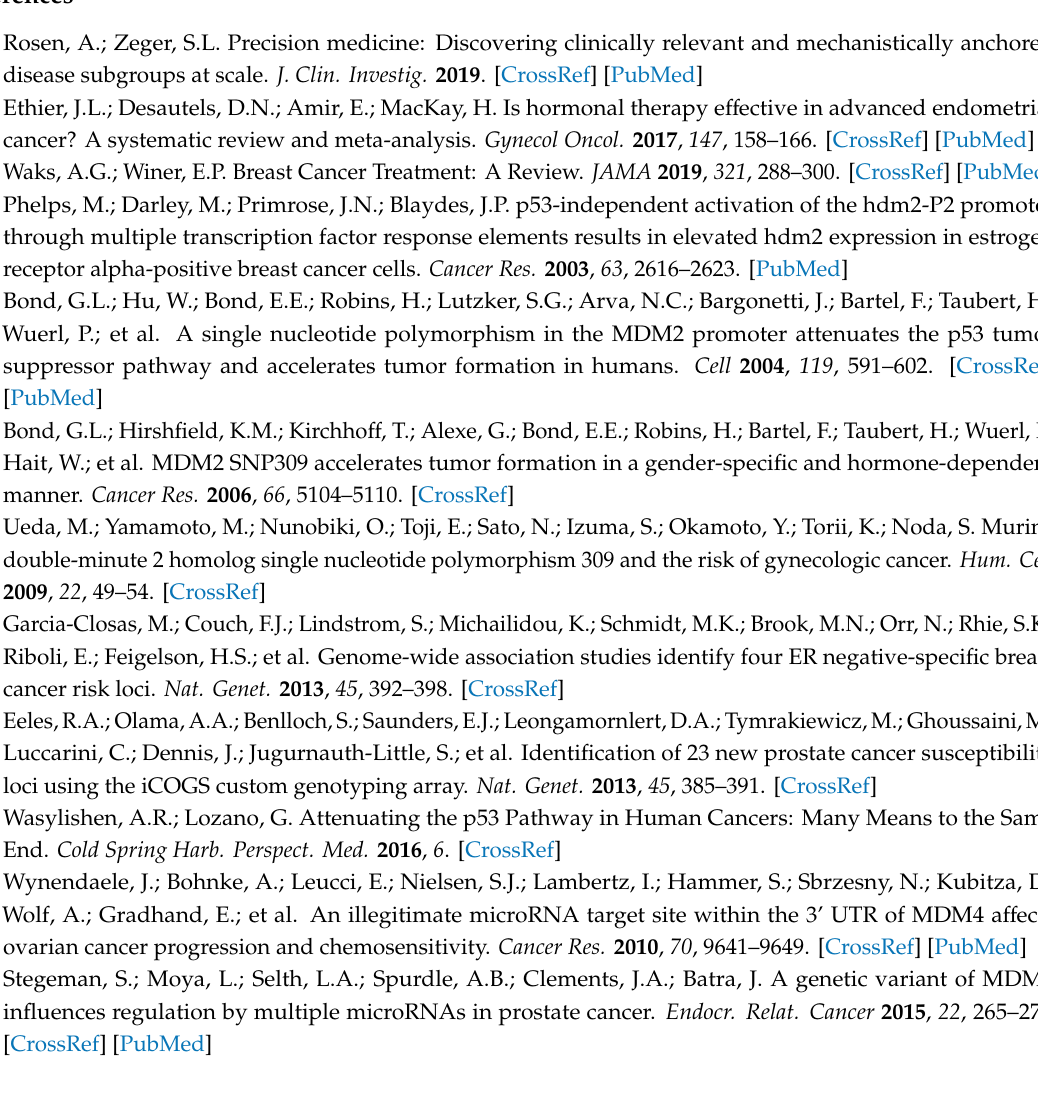
Figure S1: Analysis of protein and tumor latency in WT and Mdm4 Tg mice, Figure S2. Growth curve of fibrosarcoma and mRNA levels of estrogen-targets in WT and Mdm4 Tg mice, Figure S3. Analysis of estrogen pathway and MDM4 in estrogen-sensitive and–insensitive tumor cell lines, Figure S4. Analysis of ERa localization and ERa / MDM4 interaction, Figure S5. Analysis of total MDM4 levels in HGSOC patients, Table S1. P53 status in fibrosarcoma of Mdm4 Tg and WT mice, Table S2. mRNA levels of indicated genes in thymocytes from WT and Mdm4 Tg mice, Table S3. Clinical-pathological features of the overall